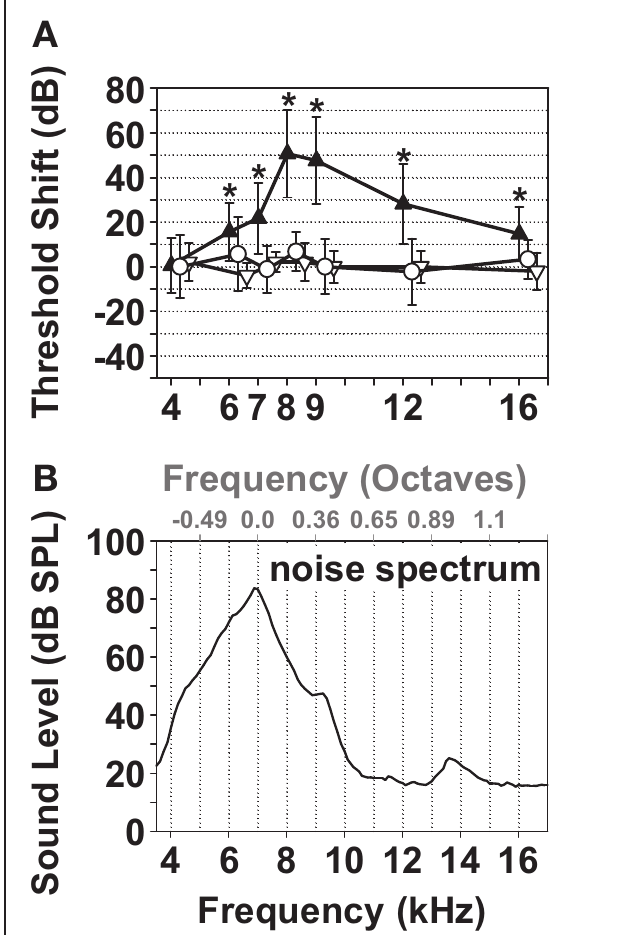
FIGURE 3 | Characterization of the narrow band noise over-exposure protocol leading to TTS. (A) ABR threshold shift pre-exposure vs. immediately after the noise overexposure (black triangles) and one and two weeks after the exposure (white triangles and dots). The mean and standard deviation of the 1st and/or 2nd noise exposures (17 ABRs) of 13 animals are shown for the immediate (1h) threshold shift (black triangles), one week (three animals/fiveABRs; white triangles) and 11–14 days after the noise exposure (seven animals/nine ABRs; white dots). ∗ Marks significance in one-sample t -test against a mean threshold shift equaling 0 performed for each test frequency: p < = 0 . 001. (B) Noise Spectrum centered at